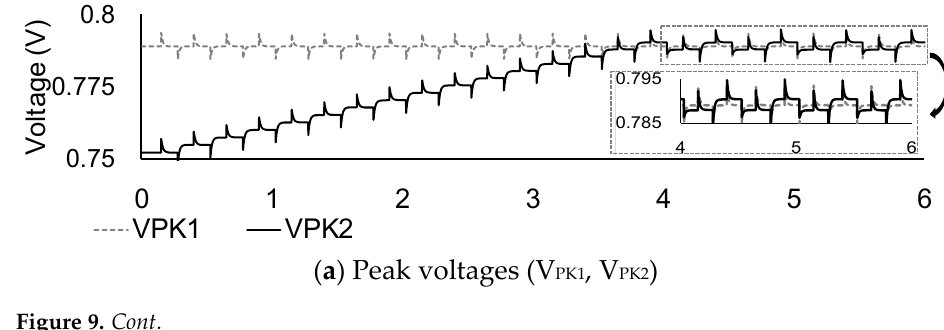
Figure 8. Block diagram of adaptive amplitude tuning with the OPAMP class-AB output stage and current replica cell with bus lines.